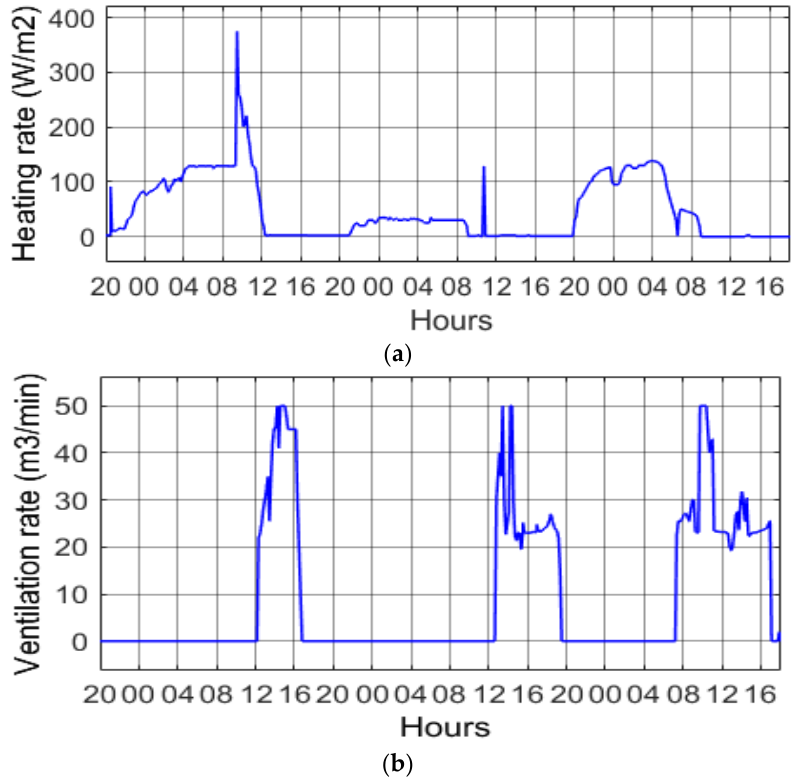
Figure 15. Heating rate ( a ) and ventilation rate ( b ) computed from the fuzzy controller.